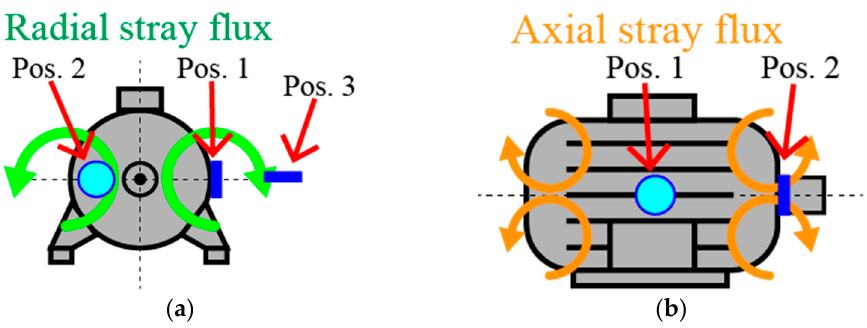
Figure 1. Common placements for the use of coil sensors to capture magnetic stray flux signals in their radial and axial components: ( a ) view from the radial plane; ( b ) view from the axial plane.